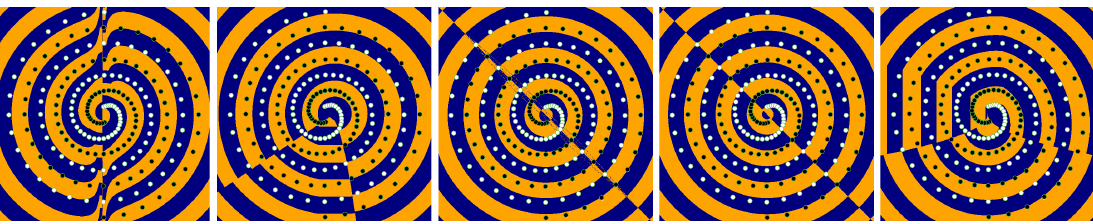
Fig. 2. Output examples from a GP classification run. Positive and negative samples are drawn as white and black dots, while the pattern produced by the GP individual is drawn as light orange or dark blue.